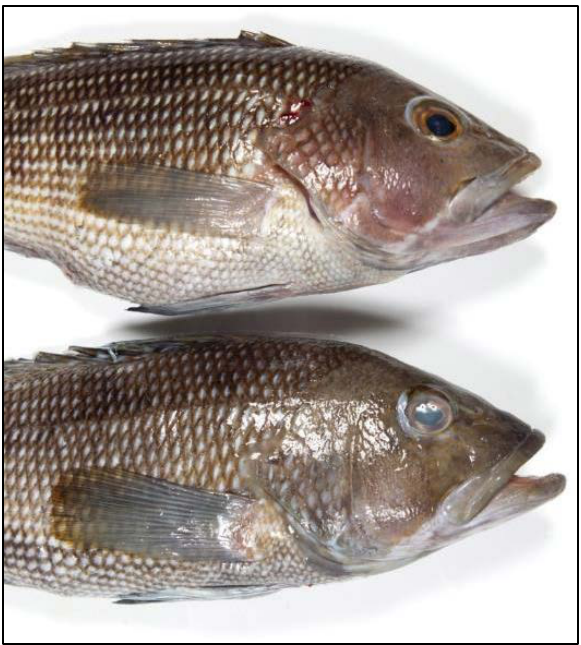
Figure 1. Whole fish: bottom fish is older eyes are clouding over. (Source: Florida Sea Grant).